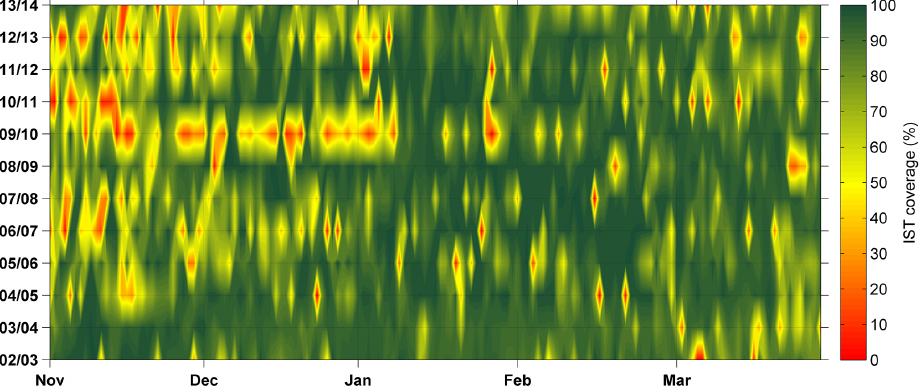
Figure 2. Interannual overview of the daily ice-surface temperature (IST) coverage (in %) within the applied polynya mask (compare Fig. 1). Values are derived from daily MODIS IST composites for the complete investigation period from 2002/2003 to 2013/2014 (November– March).